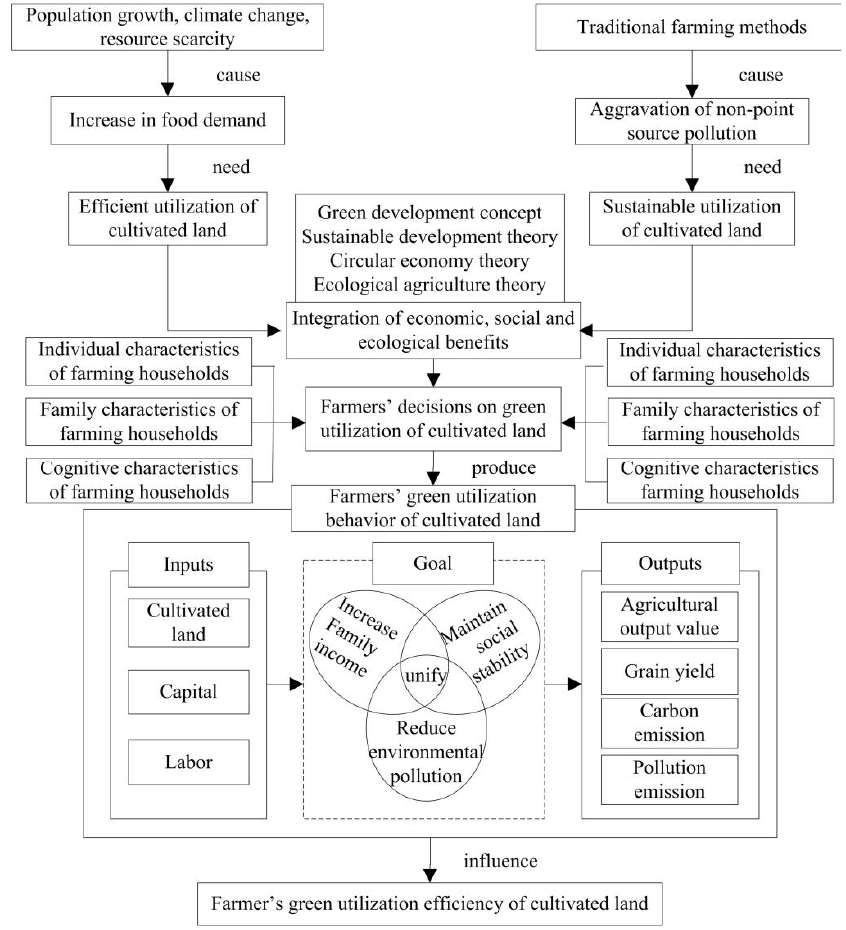
Figure 2. Theoretical analysis framework of farming households’ green utilization efficiency of cultivated land.